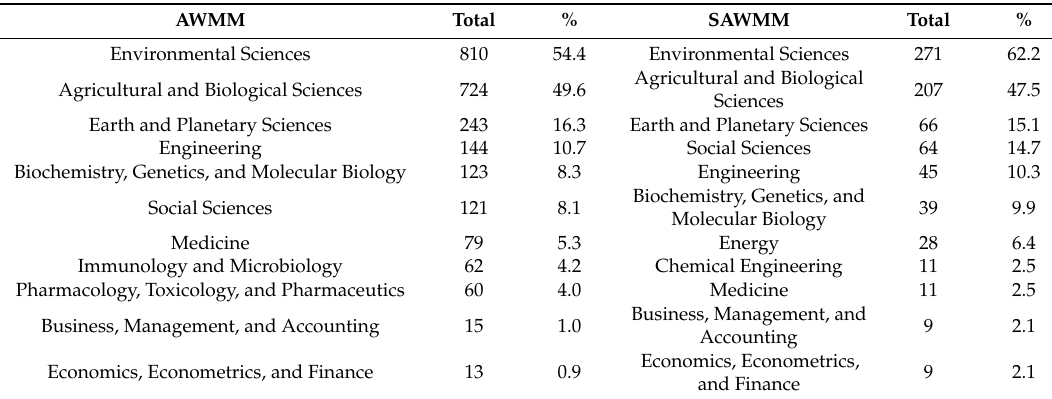
Table 2. Number of articles published by subject